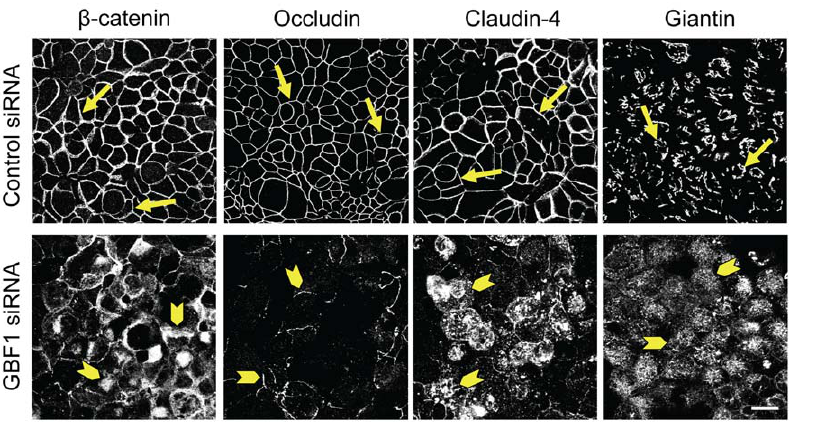
Figure 10. Downregulation of GBF1 expression phenocopies the effects of a SNAP depletion on epithelial junctions. Immunofluorescence labeling shows formation of normal b -catenin-based AJs, occludin/claudin-4-based TJs and well-organized perinuclear Golgi ribbon (arrows) in control SK-CO15 cell monolayers. In contrast, GBF1-depleted cells display a defective AJ/TJ assembly, intracellular localization of junctional proteins and dispersed Golgi (arrowheads) on day 4 post-transfection. Scale bar, 20 m m.